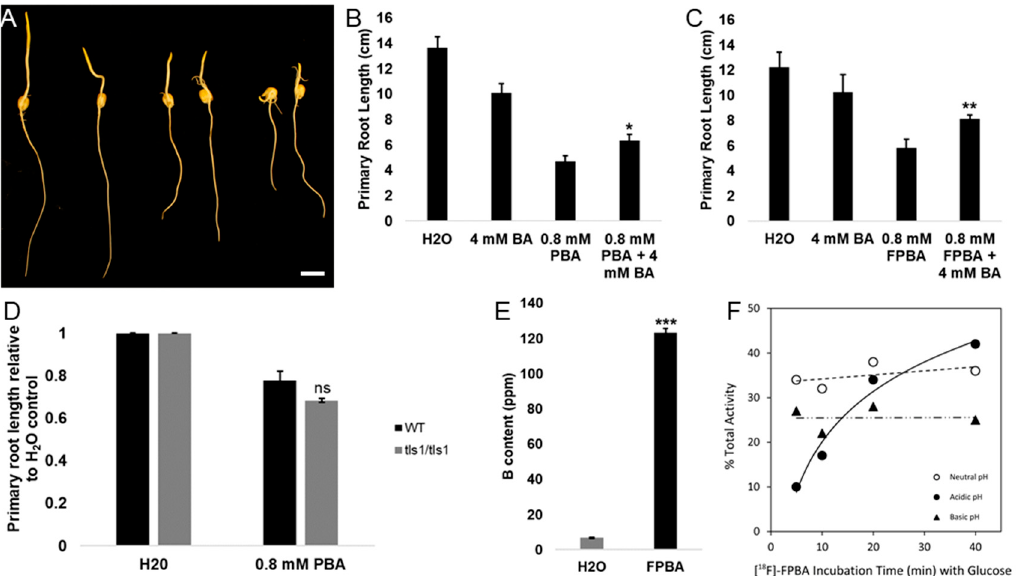
Figure 3. Mimicking of B deficiency symptoms by PBA/FPBA. A ) Rescue of PBA/FPBA induced primary root length defects by BA. From left to right: Seedlings germinated for five days in H 2 O, 4 mM BA, 0.8 mM PBA, 0.8 mM PBA + 4 mM BA, 0.8 mM FPBA, 0.8 mM FPBA + 4 mM BA. B ) Statistical analysis of primary root length of the rescue of PBA induced primary root length defects by BA as exemplified in A ). Shown is an individual experiment. C ) Statistical analysis of primary root length of the rescue of FPBA induced primary root length defects by BA as exemplified in A); shown is an individual experiment. D ) Analysis of primary root lengths relative to H 2 O control for Zmtls1 and normal seedlings grown for five days in either H 2 O or 0.8 mM PBA. E ) B measurements via ICP-MS in roots of seedlings germinated for five days in either H 2 O or 2 mM FPBA. F ) Binding affinity curves of [ 18 F]FPBA to glucose at acidic, neutral, and basic pH conditions (pH = 4.0, 6.4, and 9.0 respectively). Scale bar in A) = 2 cm. * p < 0.05, ** p < 0.01, and *** p < 0.001 (Student’s t-test). ns = non-significant.